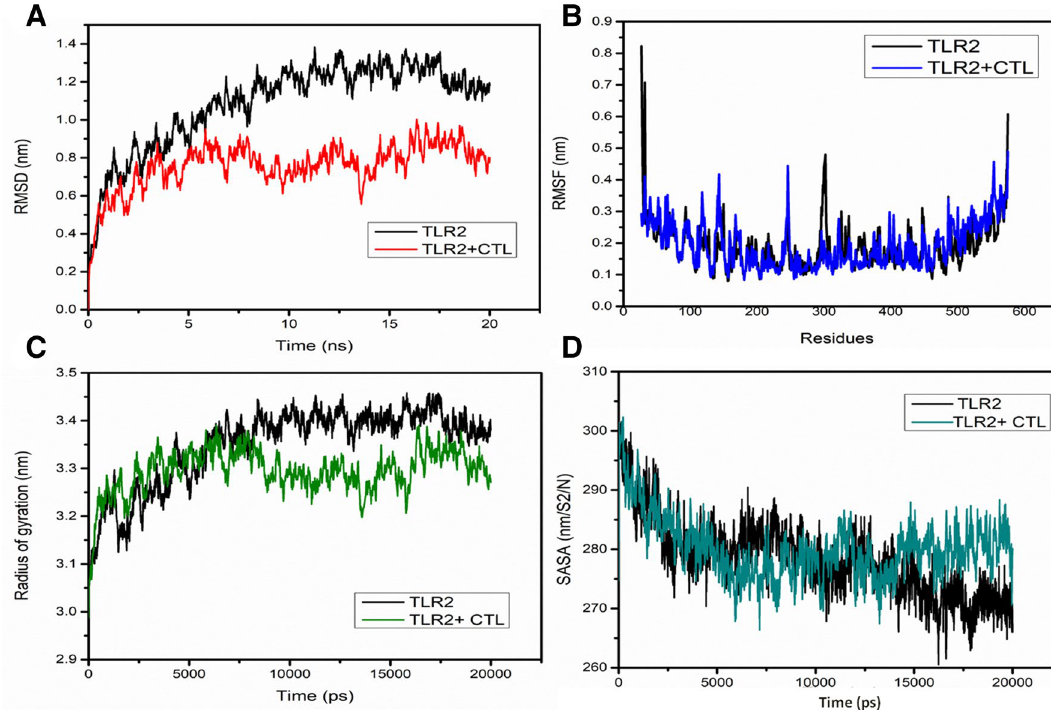
Figure 3. The stability of the TLR2 and TLR2-CTL epitope complex as predicted by molecular dynamics simulations. ( A ) RMSD profile of TLR2 (black traces) and TLR2-CTL(red traces) epitope. ( B ) RMSF profile of TLR2 (black traces) and TLR2-CTL epitope (blue traces). ( C ) Radius of gyration plots of TLR2 (black traces) and TLR2-CTL epitope (green traces). ( D ) SASA profile of TLR2 (black traces) and TLR2-CTL